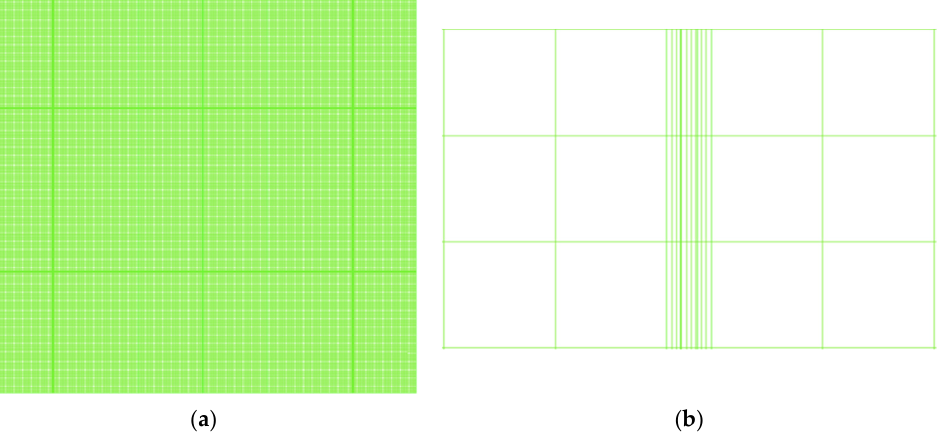
Figure 2. ( a ). Mesh generation for modelling pipeline leakage. ( b ). Partial enlarged view of leakage orifice. leakage